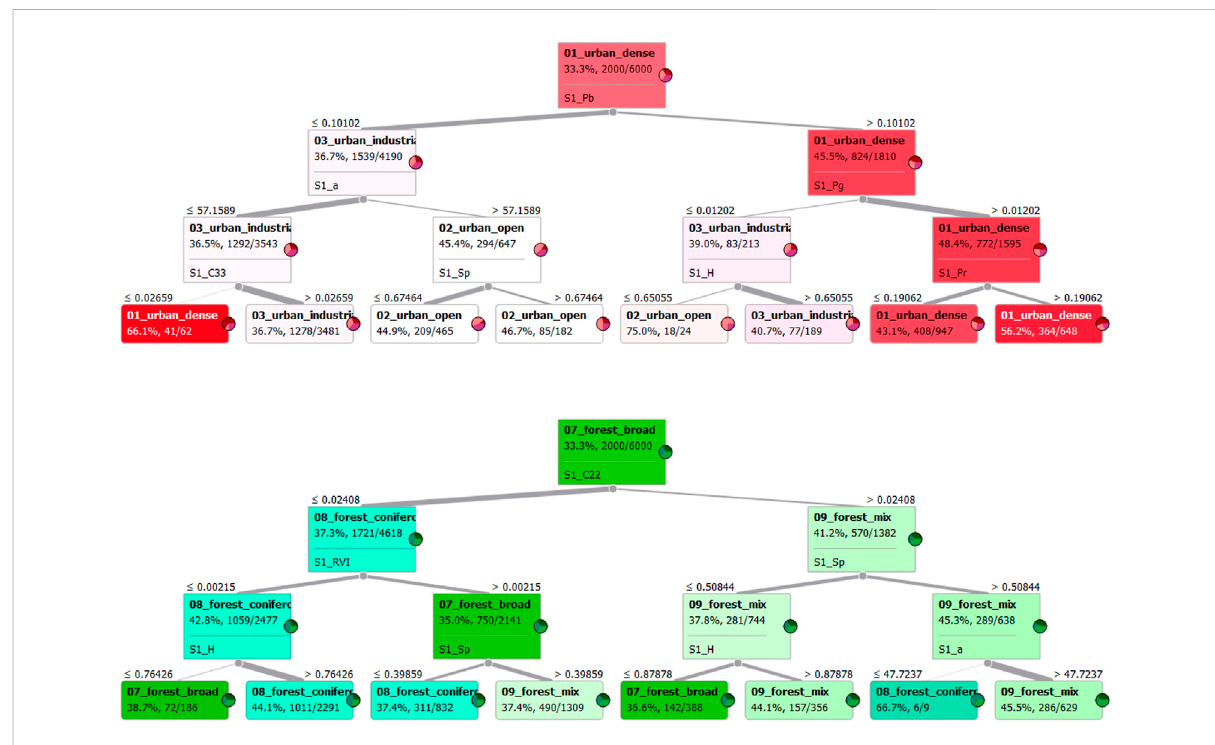
FIGURE 12 Classi fi cation trees of urban (top) and forest (bottom) classes based on all available pseudo-polarimetric variables (Table 1). Each node represents a subset of training samples from the level above which are split by the most impactful variable and threshold. Color tones and pie charts indicate class composition and